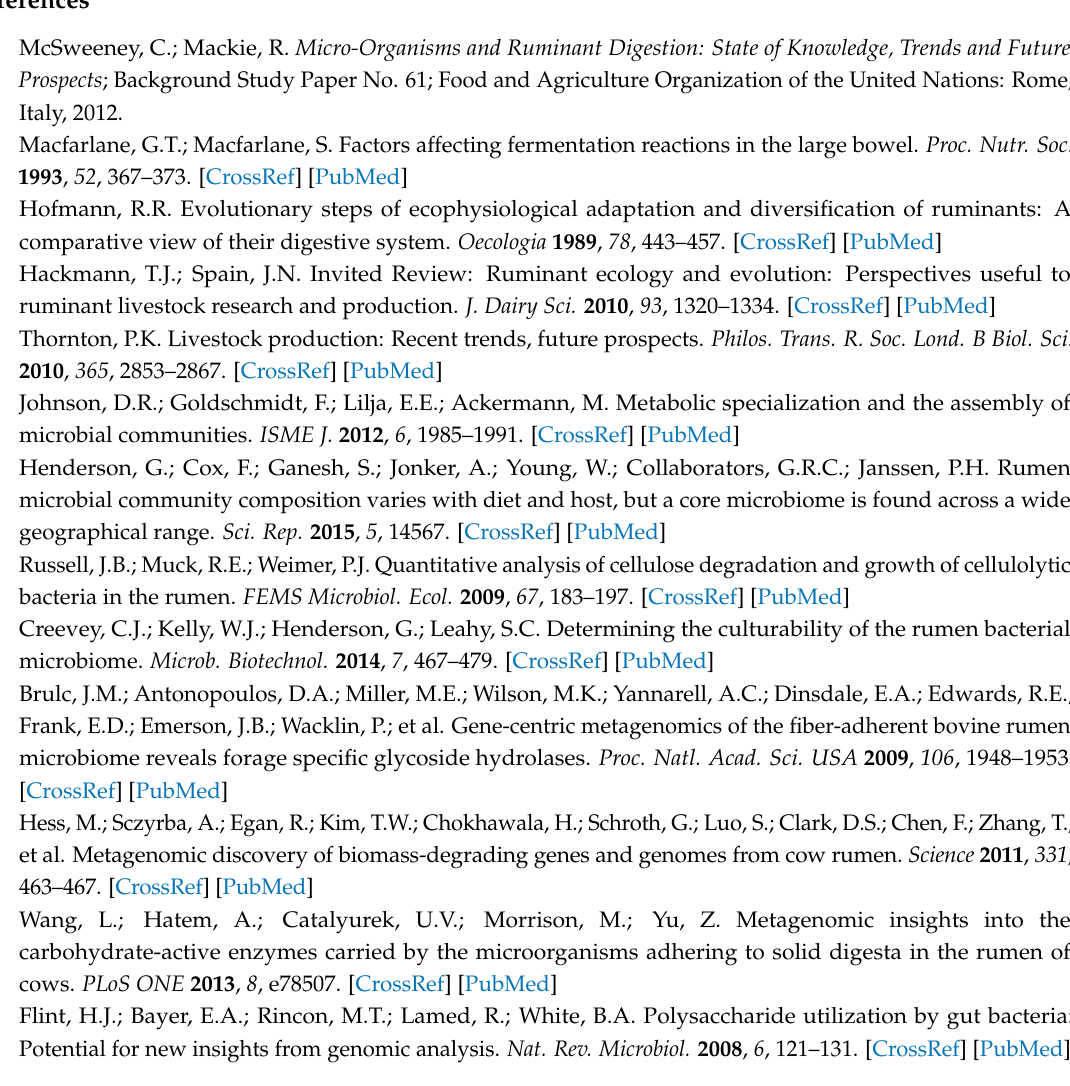
Figure S1: Rarefaction analysis of sequence read coverage for each sample, Table S1: Read numbers, average quality scores, and SRA accession numbers for 16S rRNA reads used in analysis of each sample, Tables S2–S4: Relative abundance of each OTU identified from rumen samples and rumen-derived